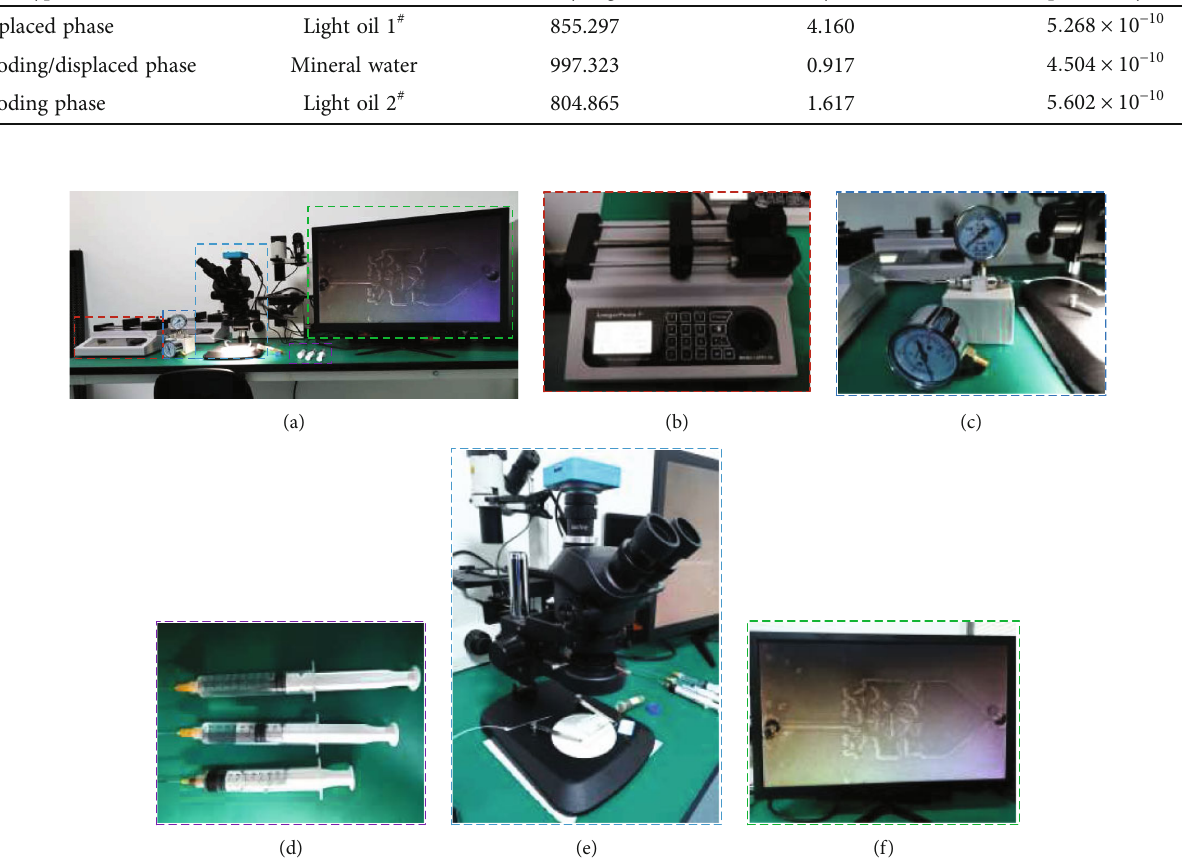
Figure 2: The micro fl uidic experiment scheme of water-oil fl ow: (a) overview of experimental equipment; (b) microinjection pump; (c) capsule pressure gauge (16 kPa) and alloy four-way valve; (d) medical plastic syringes; (e) optical microscope with electron lens and micro fl uidic chip; (f) screen and data record.